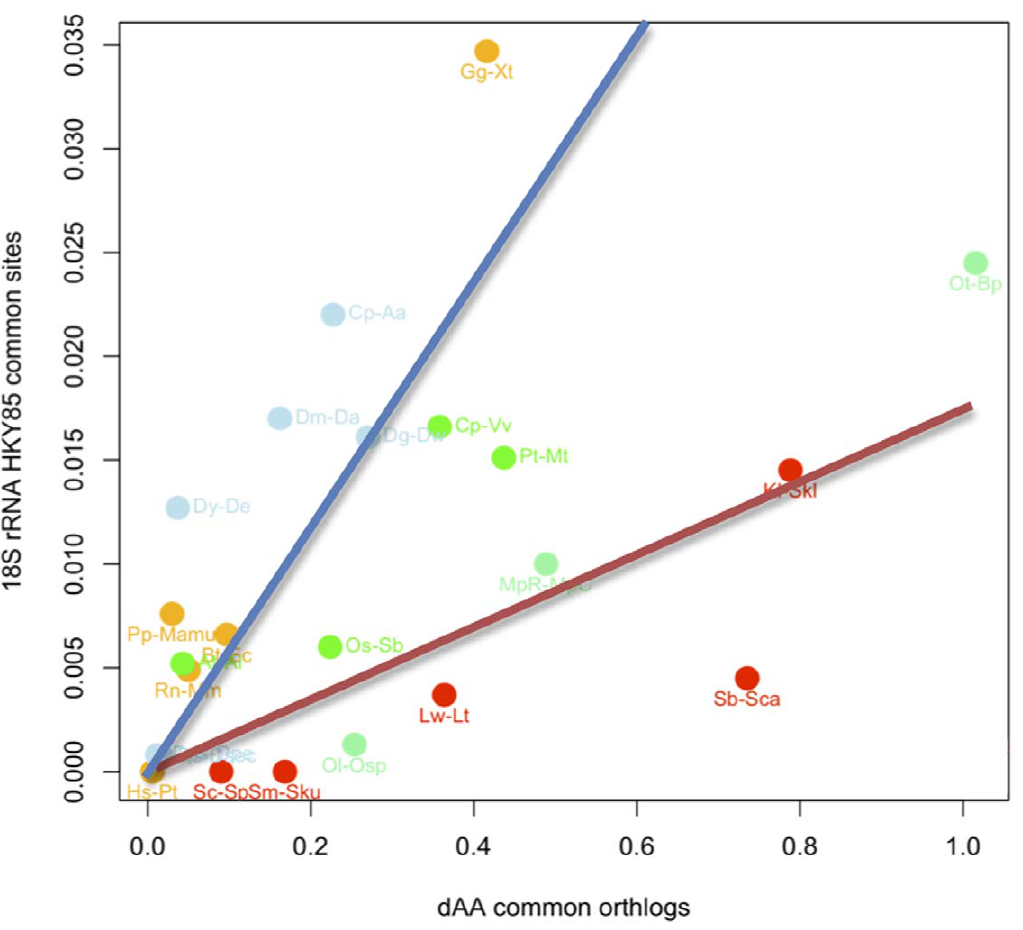
Figure 2. 18s rDNA evolution rates versus Amino-acid evolution rates for all common orthologous genes within lineages for independent pairs of species. Yellow: Vertebrates, Green: Streptophytes, Light blue: Diptera, Light green: Chlorophyta, Red: Saccharomyceta. doi:10.1371/journal.pone.0016342.g002 PLoS ONE |